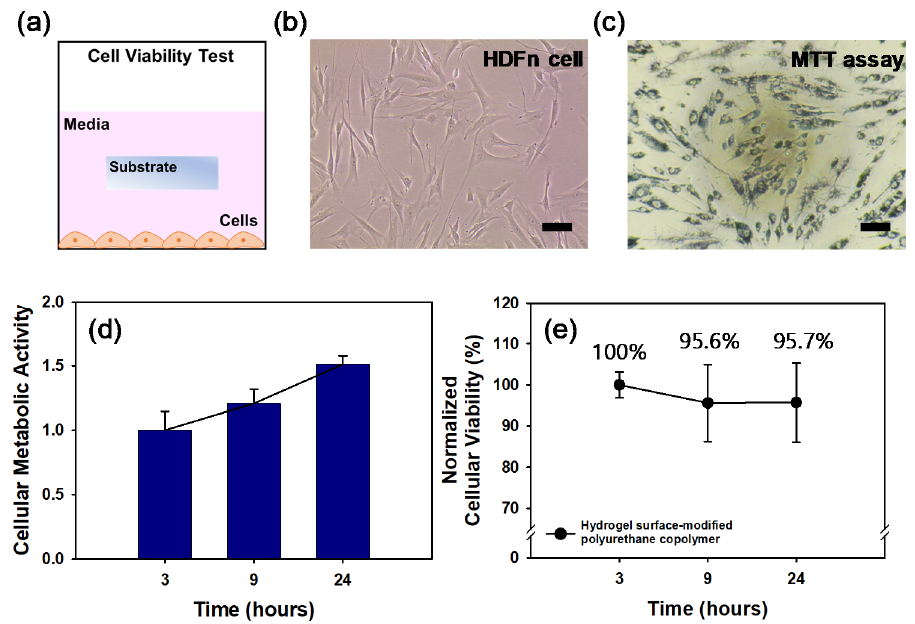
Figure 7. ( a ) Schematic design of cell viability test. Bright field images are Human dermal fibroblasts (HDFn) ( b ) on culture plate and ( c ) MTT assay for cytotoxicity. (scale bar; 100 µ m) ( d ) The cellular metabolic activity measured at each time was normalized to the metabolic activity characterized right after cell stabilization on well. ( e ) The cell viability measured at each time was normalized to the characterized pure medium group at each time, comparing to the hydrogel surface-modified polyurethane copolymer.